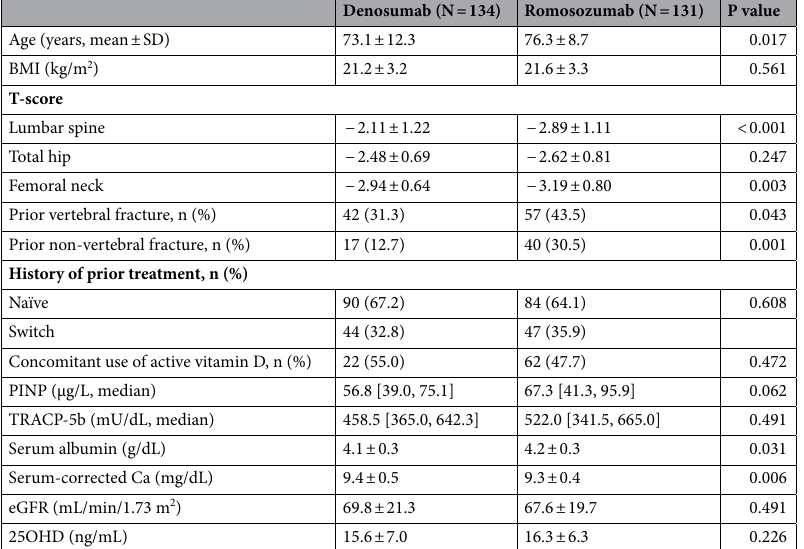
Table 1. Demographic and clinical characteristics of subjects at baseline before extraction by propensity score matching. Data are expressed as the mean ± standard deviation (SD) or the number (%) of all patients who completed 12 months of denosumab or romosozumab treatment. P1NP and TRACP-5b are expressed as median values. BMI body mass index, P1NP procollagen type 1 N-terminal propeptide, TRACP-5b